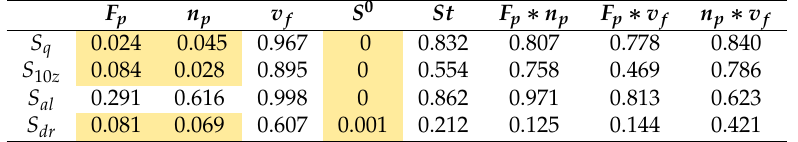
Table 5. The p -values obtained for all ANOVA calculations. Shaded values are lower than α = 10%. F p